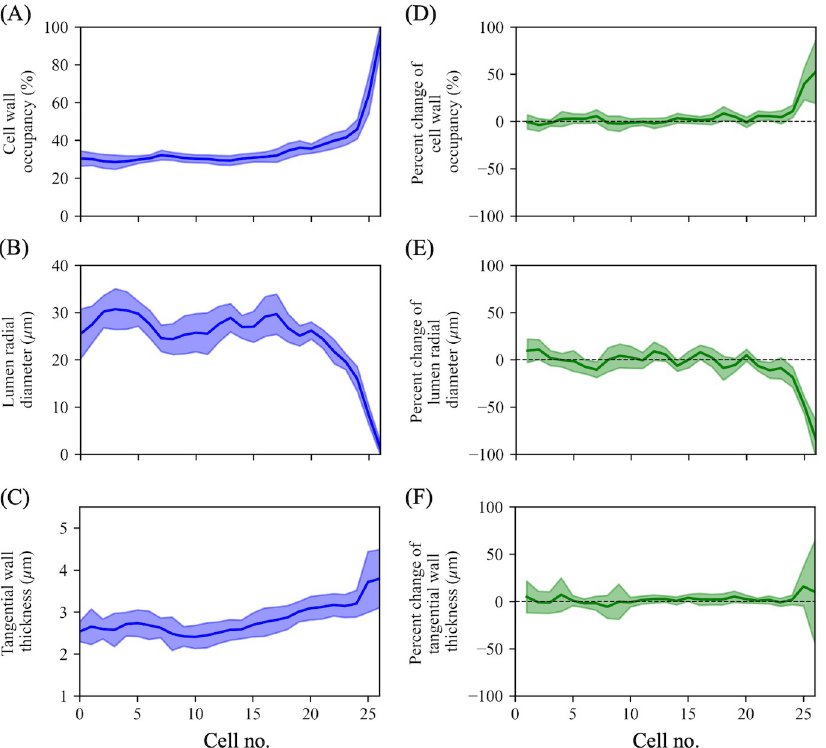
Fig 6. Normalized intra-annual transitional behaviors of a portion of the anatomical parameters. (A) Cell wall occupancy, (B) lumen radial diameter, and (C) tangential wall thickness, respectively. (D–F) Percentage changes of each anatomical parameter (A–C) from preceding tracheids. Solid lines and the shaded area surrounding them in each figure indicate the mean intra-annual transitions and their standard deviations, respectively. Cell no. 1 corresponds to the tracheid positioned at the most earlywood. Cell number ranges from no. 1 to no. 27 in normalized radial